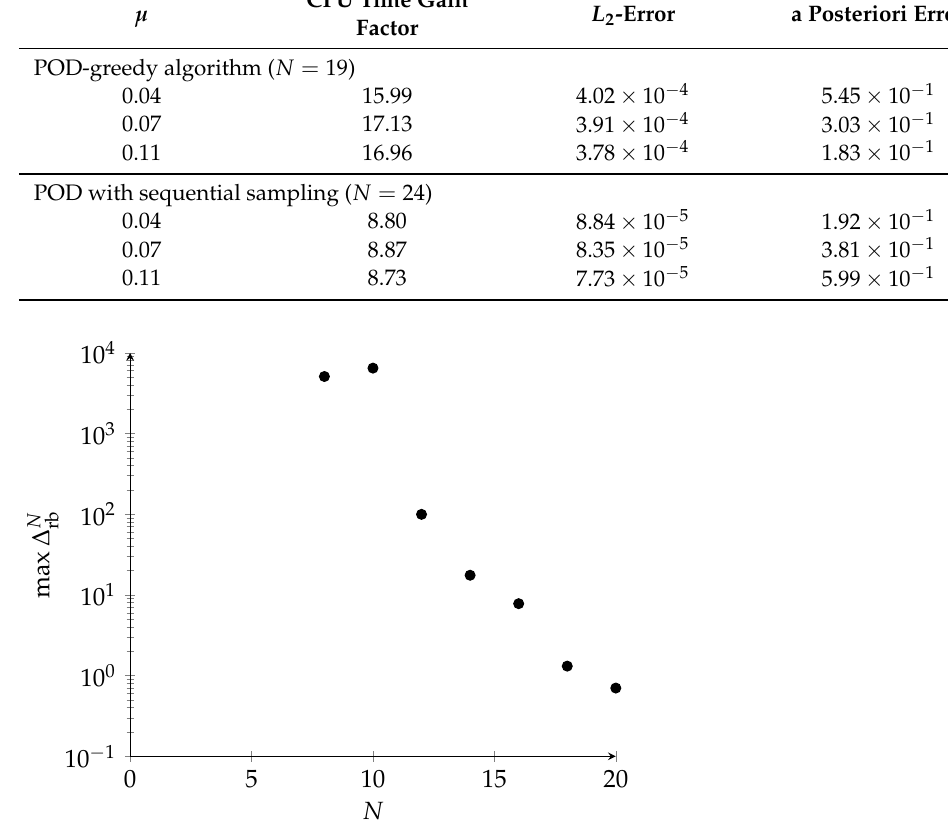
∆ N = max ( µ ) during the µ ∈ Ξ rb rb